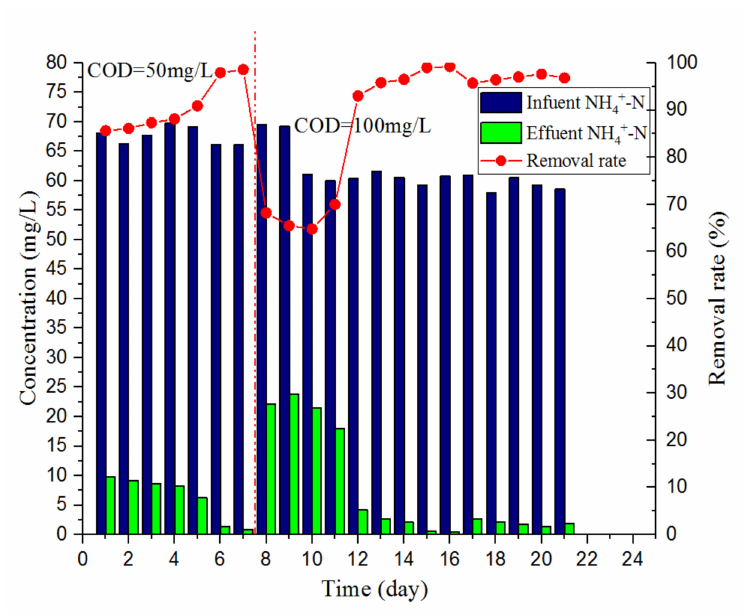
Figure 5. Changes in the content of NH 4 + -N.